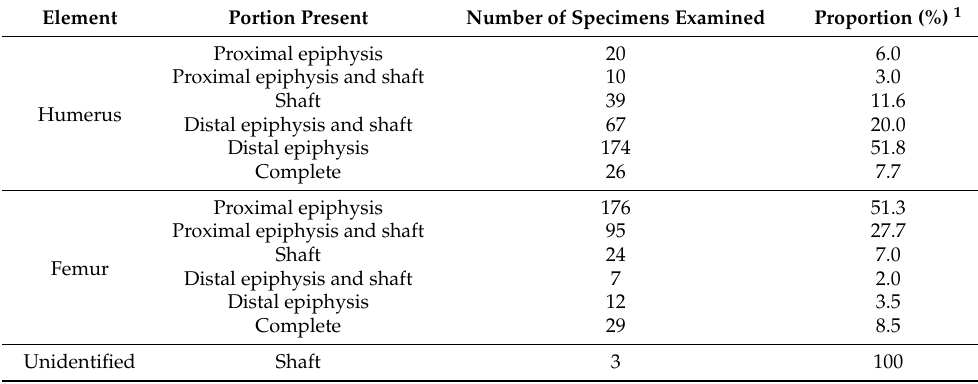
Table 2. Overall humeri and femora fragmentation data: The data are disaggregated by element and portion present. Element Portion Present